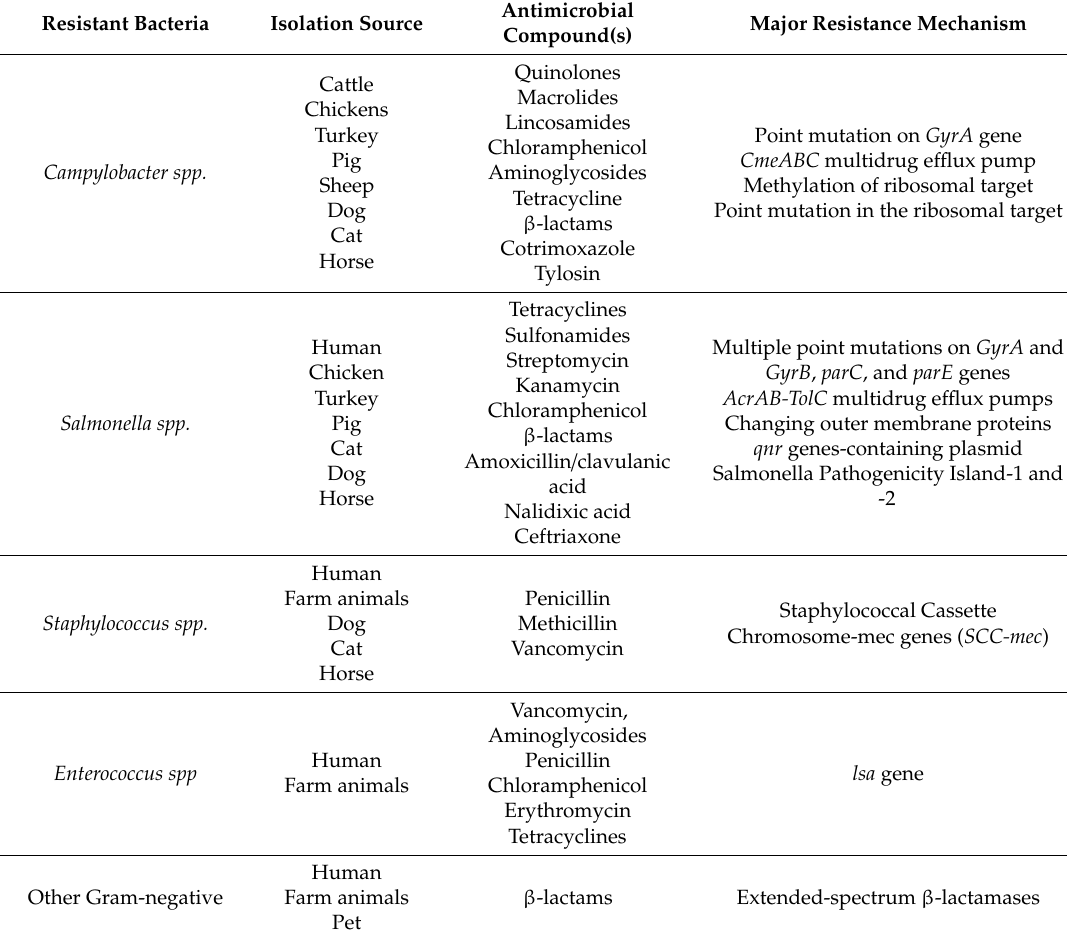
Major Resistance Mechanism Point mutation on GyrA gene CmeABC multidrug e ffl ux pump Methylation of ribosomal target Point mutation in the ribosomal target Multiple point mutations on GyrA and GyrB , parC , and parE genes AcrAB-TolC multidrug e ffl ux pumps Changing outer membrane proteins qnr genes-containing plasmid Salmonella Pathogenicity Island-1 and -2 Staphylococcal Cassette Chromosome-mec genes ( SCC-mec ) lsa gene